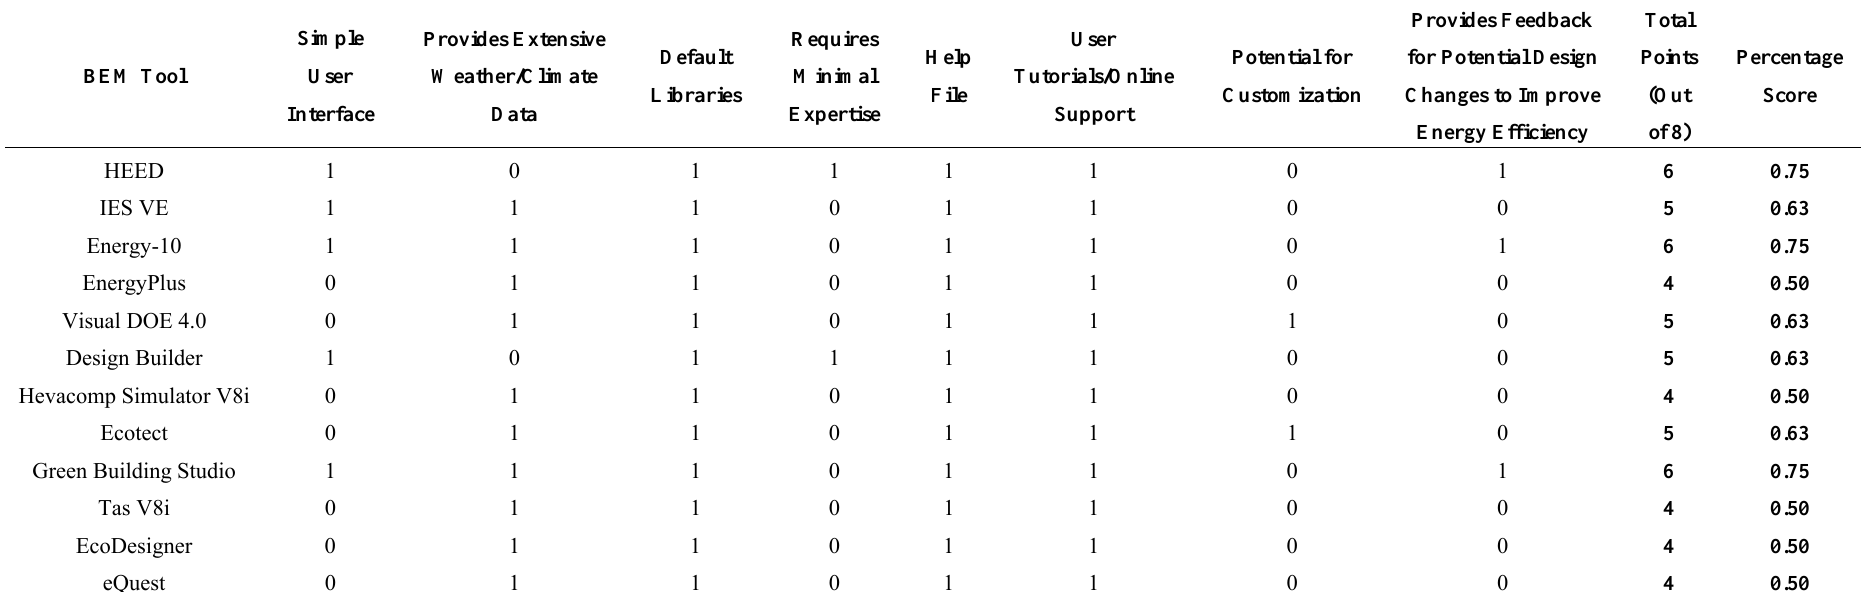
Table A2. Initial evaluation: usability criterion calculations for BEM tools.